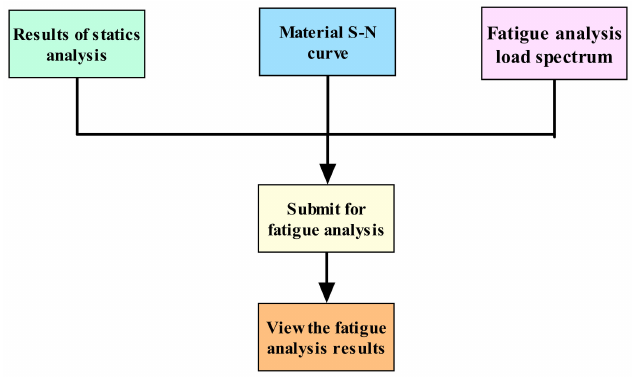
Figure 18. Fatigue analysis flow of aluminium subframe.